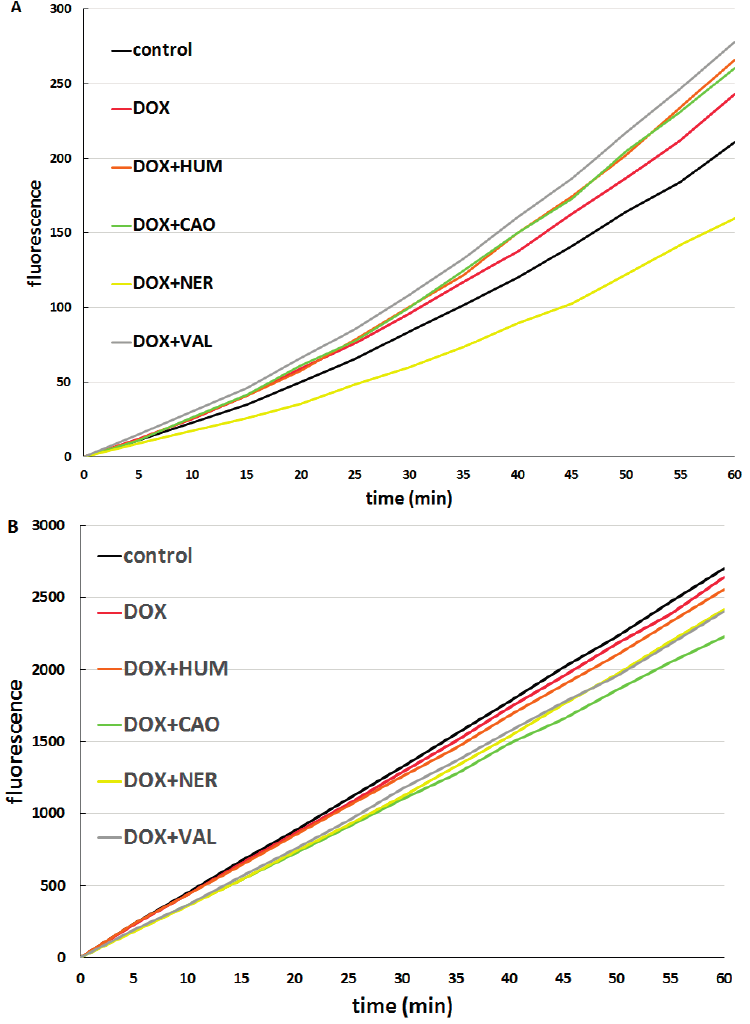
Figure 7. Effect of DOX (1 µM) alone and DOX (1 µM) + sesquiterpene (10 µg/mL) combinations on ROS formation in CaCo-2 cells ( A ); and hepatocytes ( B ). The effect of sesquiterpenes on DOX accumulation in cells was also studied. Concentrations